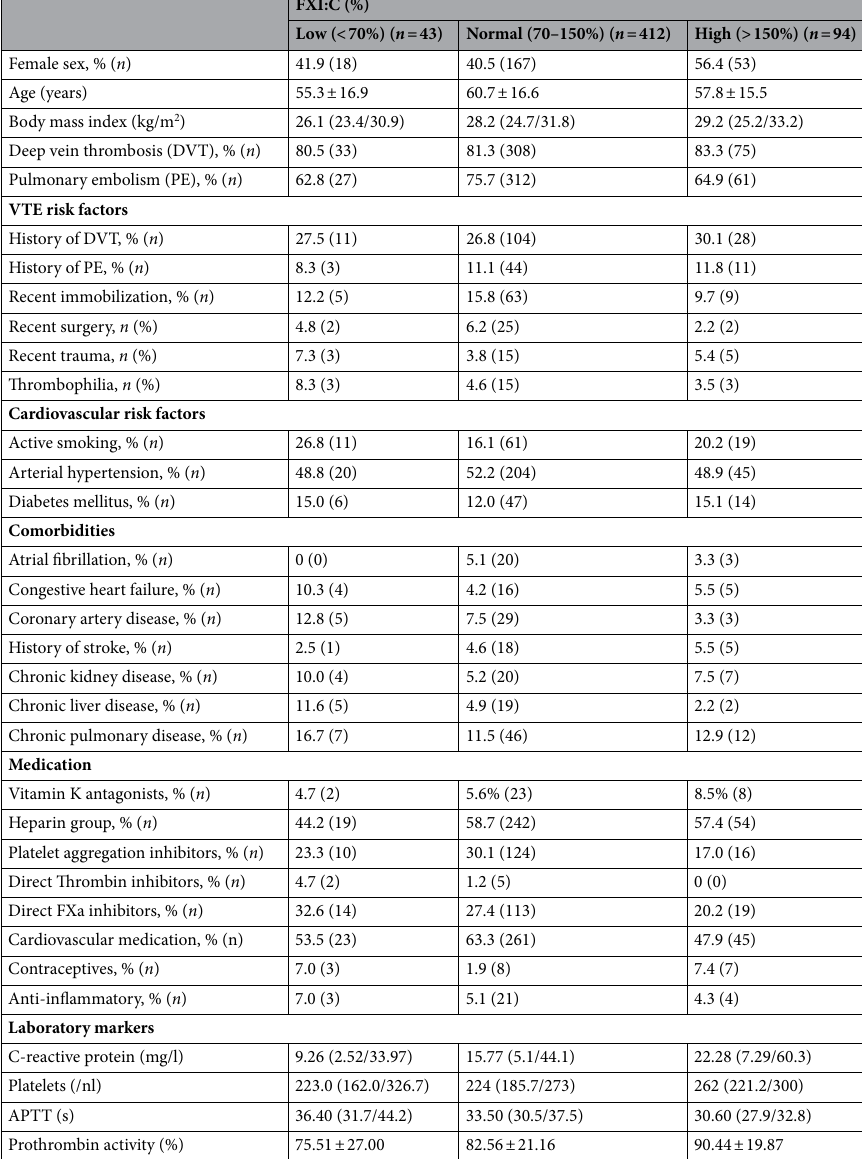
Table 1. Baseline sample characteristics, stratified by categories of FXI:C (%). Single numbers indicate mean and standard deviation, or median (interquartile range). Cardiovascular medication comprised cardiac therapy (ATC Code C01), antihypertensives (C02), diuretics (C03), vasoprotective agents (C05), beta blocking agents (C07), calcium channel blockers (C08), agents acting on the renin-angiotensin system (C09) and lipid modifying agents (C010). APTT indicates activated partial thromboplastin